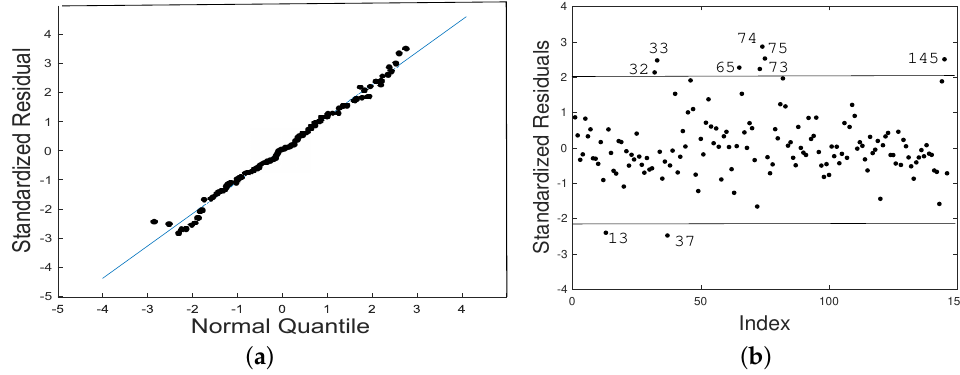
Figure 3. QQ plot for standardized residuals ( a ) and plot of index values versus standardized residuals ( b ) for Student-t PCVM (Santiago data). Table 2. Maximum penalized likelihood estimates with corresponding estimated SE and AIC value under Student-t ( ν = 4) model. Parameter